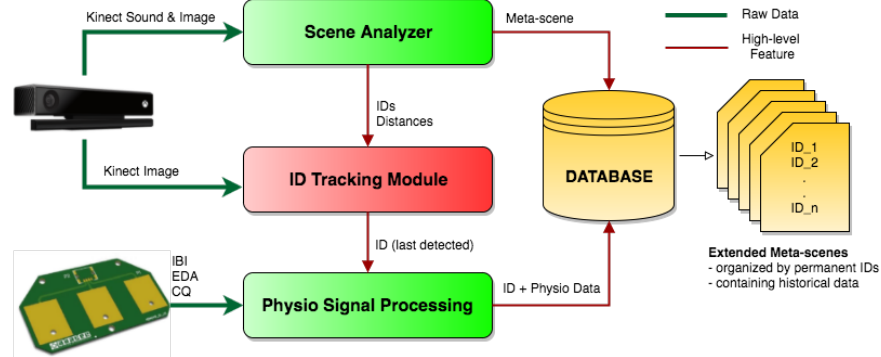
Figure 7. Flowchart of the subjects information flow managed by the ”ID Tracking Module”. This schema reports how the subject ID is detected and maintained, even in case of camera occlusion, thanks to the synergy between the two different acquisition systems modules: ”Scene Analyzer” and ”Physio Signal